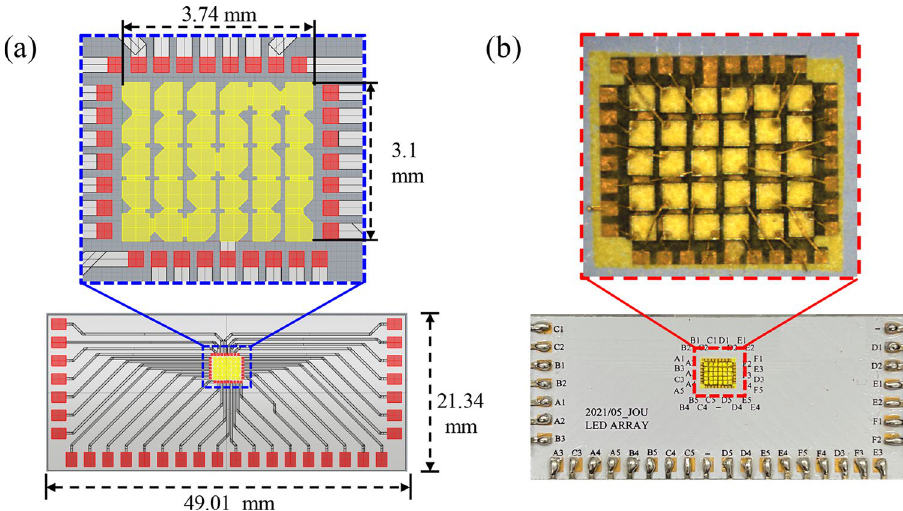
Figure 5. ( a ) The designed arrangement of the LED dies and the MCPCB layout. ( b ) The corresponding sample.